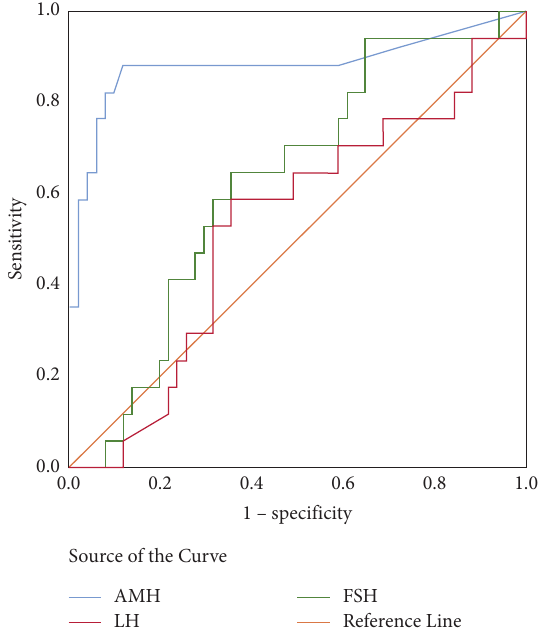
Figure 2: ROC curve showing cutof values of AMH for predicting spontaneous puberty.